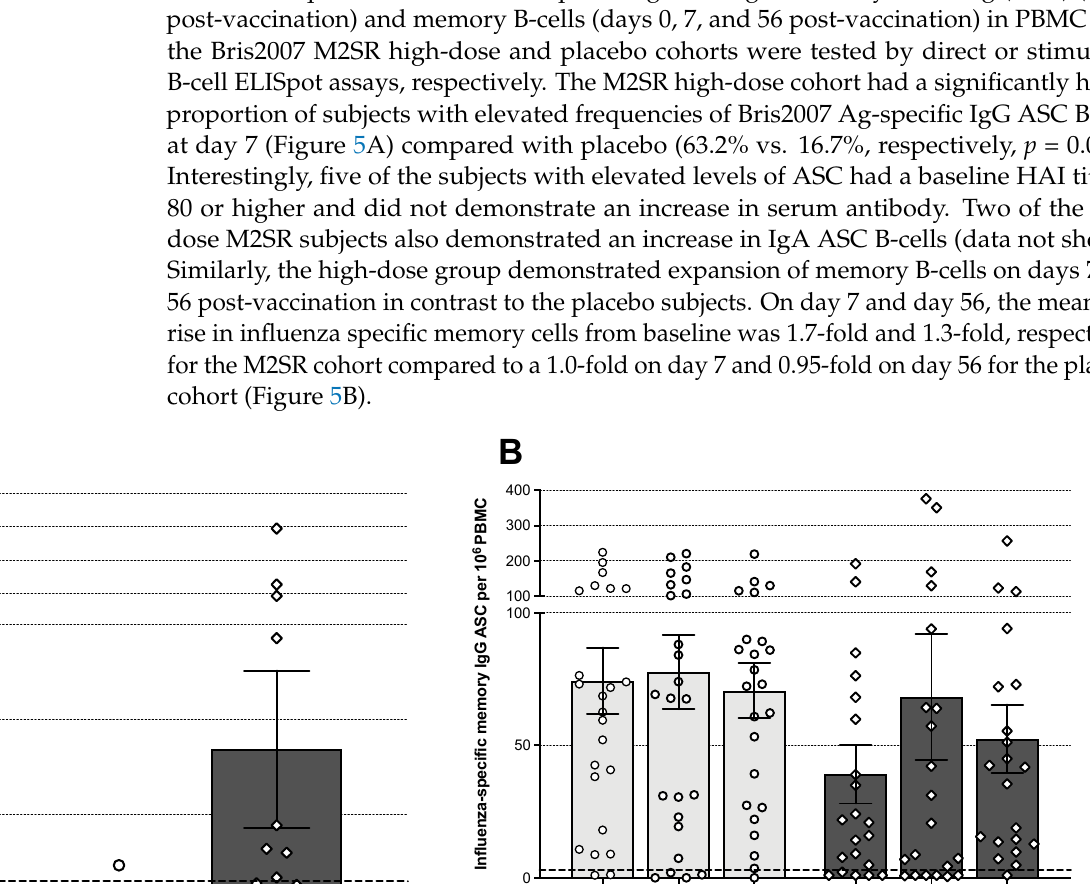
Figure 4. Influenza A/Brisbane/10/2007 HA-specific secretory IgA (sIgA) responses in nasal swabs. Shown are fold increase in HA-specific sIgA titer normalized to total IgA on day 28 post-vaccina- tion over baseline. Bars represent the geometric mean ELISA titer with error bars showing the 95% confidence interval. Each symbol represents an individual subject.